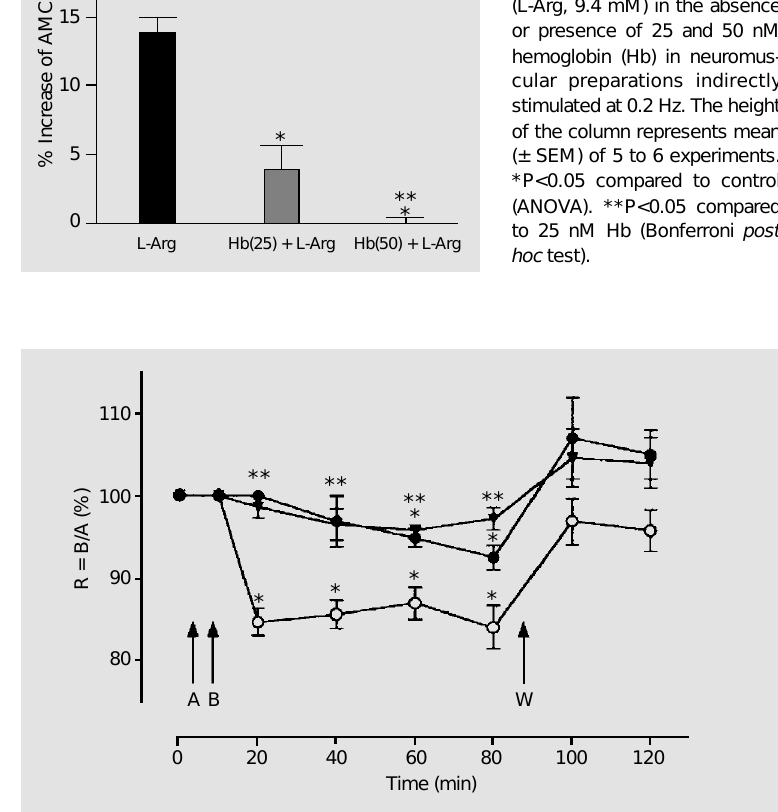
Figure 2 - Percent reduction of R values induced by L-arginine (9.4 mM) in the absence (open circles) or presence of 50 nM (filled circles) and 100 nM (filled triangles) hemoglobin in indirectly stimulated neuromuscular preparations. On the ordinate, the R ratio is ex- pressed as a percentage of that obtained for drug-free Krebs buffer, taken as 100% (t = 0). The abscissa represents time. A and B represent the times of hemoglobin and L-arginine addition, respectively. W indicates replaced drug-free Krebs buffer (4 times). Points repre- sent mean (± SEM) of 6 to 7 experiments. *P<0.05 compared to control (ANOVA). **P<0.05 compared to L-arginine in the absence of hemoglobin (Bonferroni post hoc